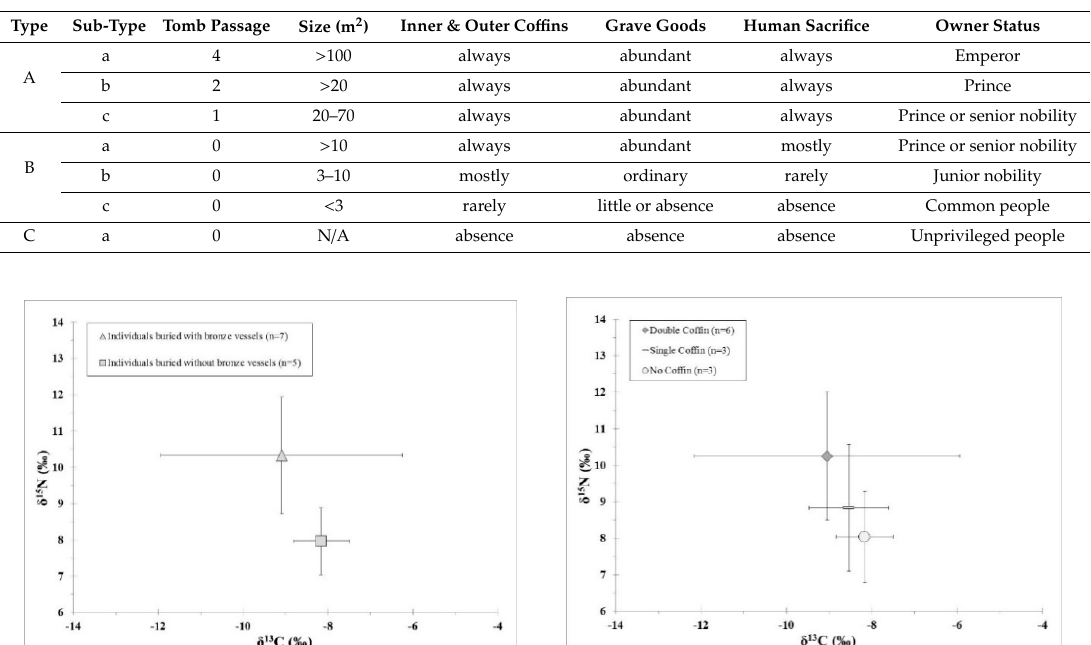
Table 4. Classification of social status for burials from the Shang and Zhou Dynasties. Note: Information is referenced from IA CASS [3].